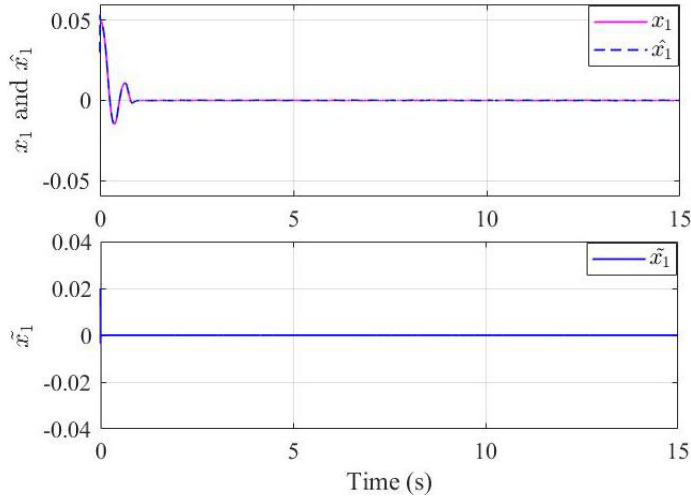
x and estimation error. 1